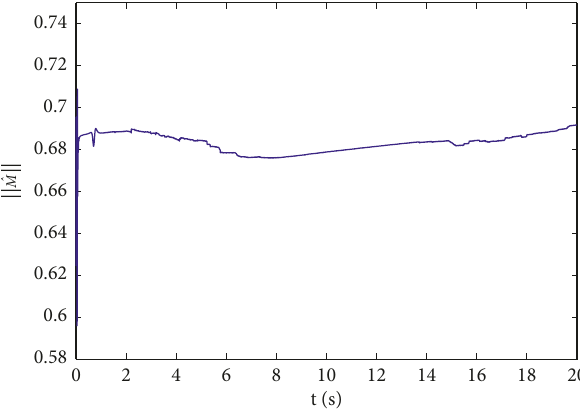
Figure 7: The norm of the RBFNN weight matrix estimation 􏽢 M